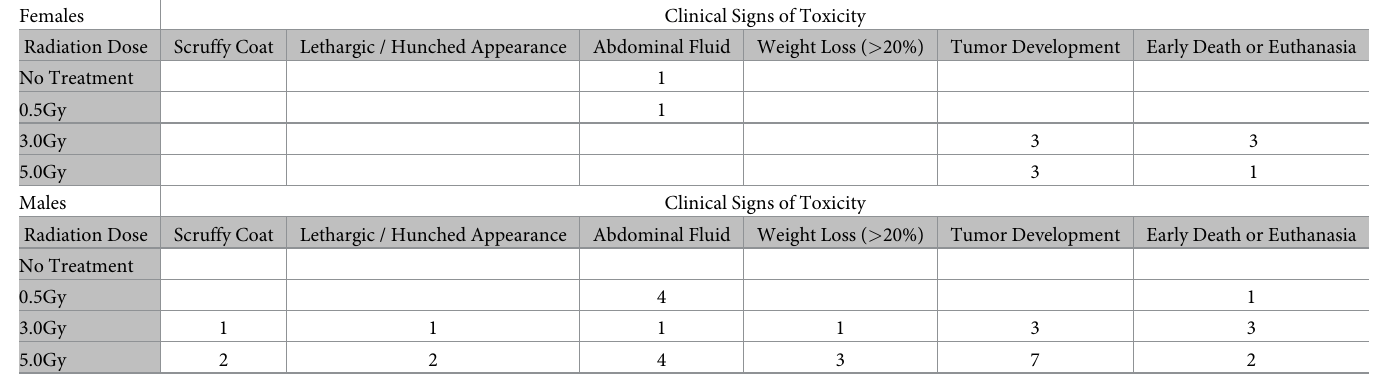
Table 1. General clinical observations one year after